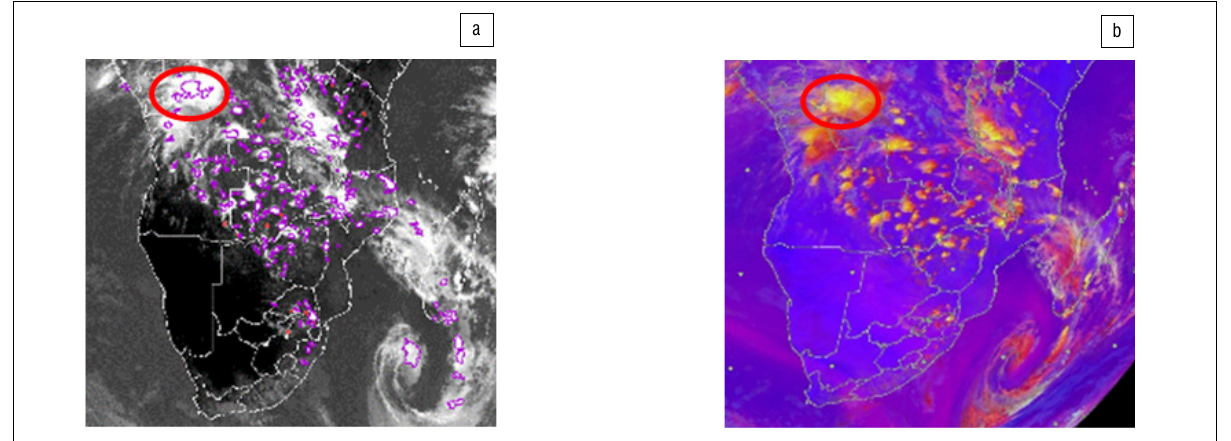
Figure 7: (a) The RDT product and (b) the convection RGB on 10 January 2014 at 12:00 UTC.